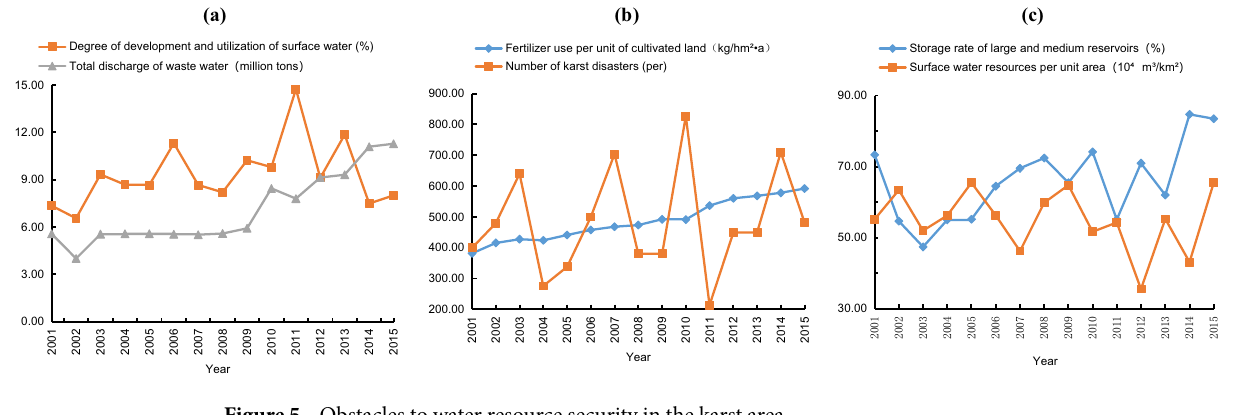
Figure 5. Obstacles to water resource security in the karst